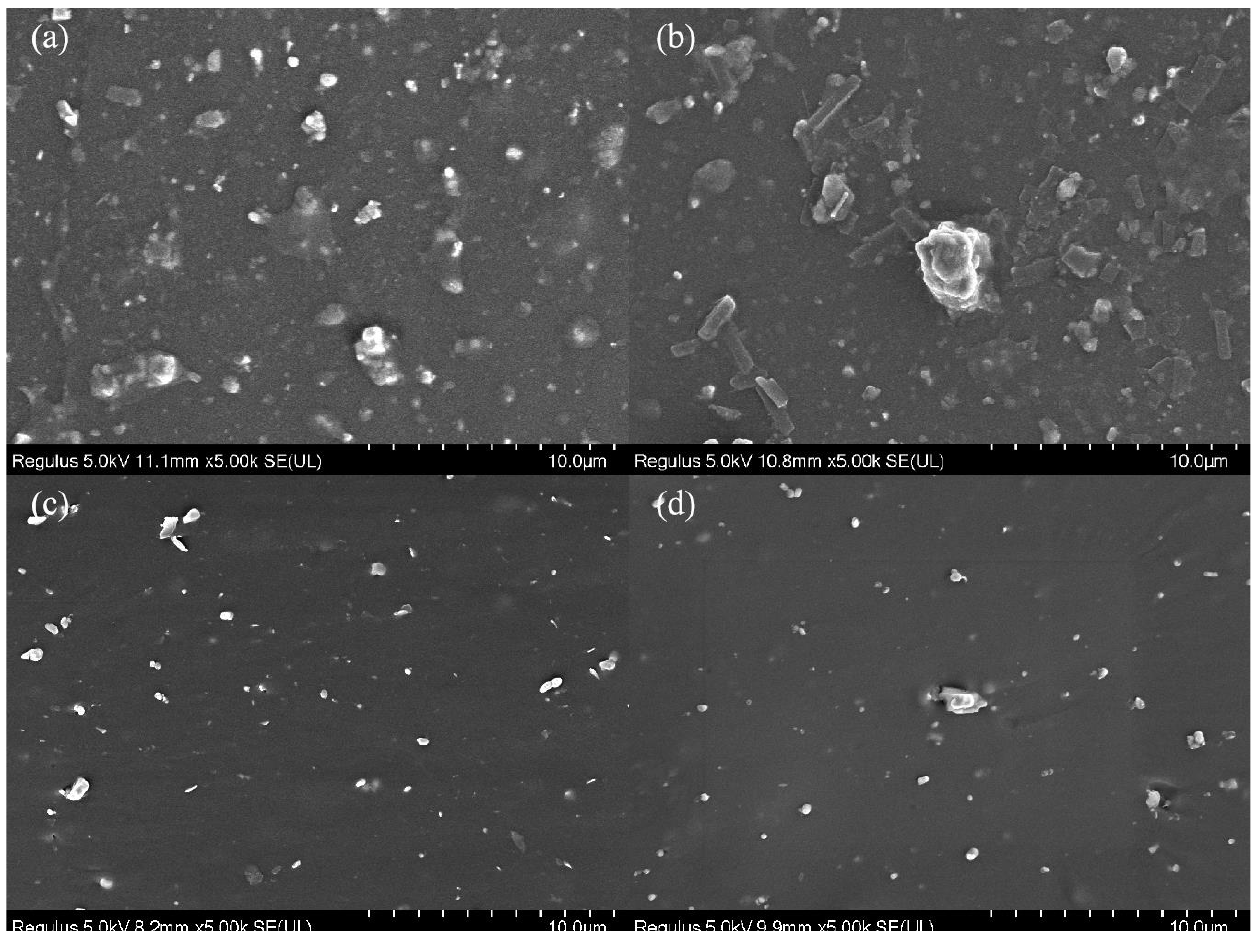
Figure 4. SEM images of ( a ) EPDM, ( b ) GO/EPDM, ( c ) AGO/EPDM, and ( d ) HGO/EPDM.